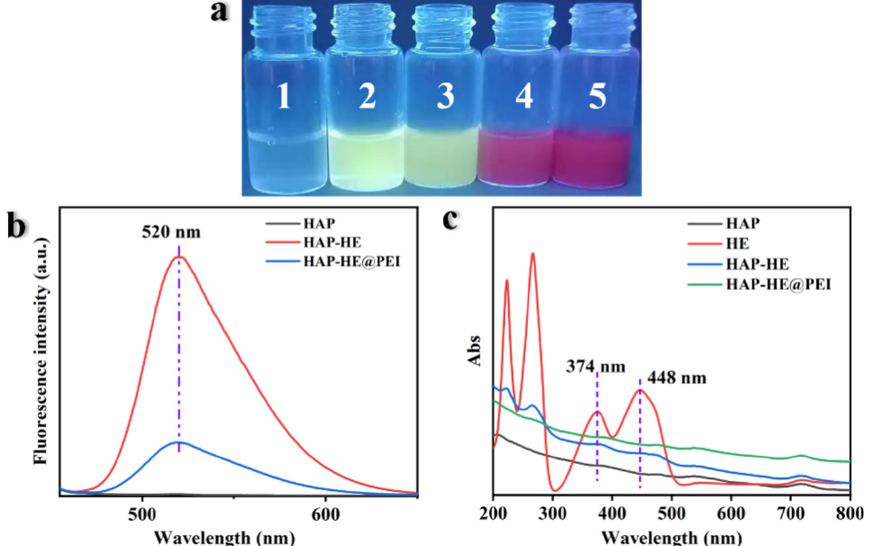
Figure 6. Fluorescence and UV Properties of samples. ( a ) The fluorescence photos of all samples in the UV light box. The numbers 1 to 5 represent HAP, HAP − HE, HAP − HE@PEI, HAP − HE@PEI@DOX and DOX, respectively. ( b ) Fluorescence spectrum (excitation wavelength: 440 nm). ( c ) UV-Vis